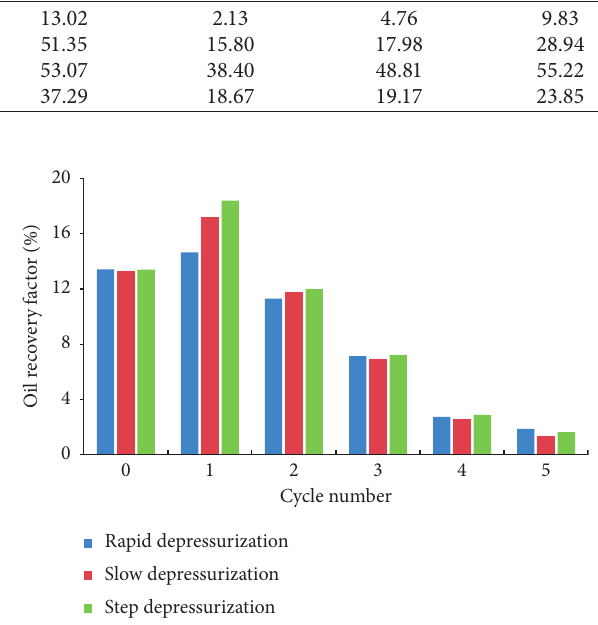
Figure 18: The oil recovery factor of depletion production period and each huff-and-puff cycle with different depressurization